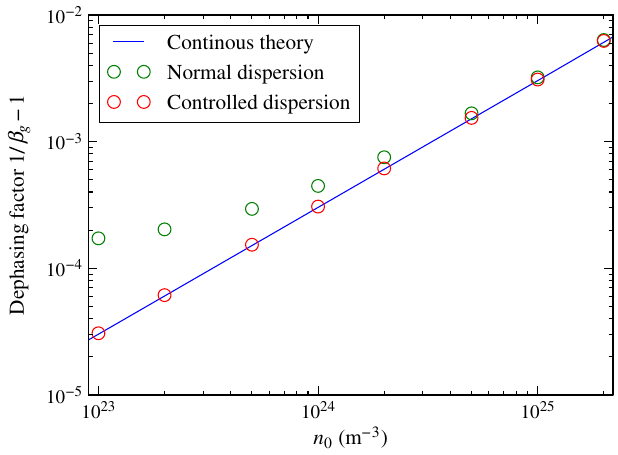
FIG. 1. The dephasing factors for normal dispersion and con- trolled dispersion simulations compared to continuous theory. n 0 is the plasma density at the bottom of the plasma channel. We plot the dephasing factor here for consistency with a similar analysis of the envelope model in